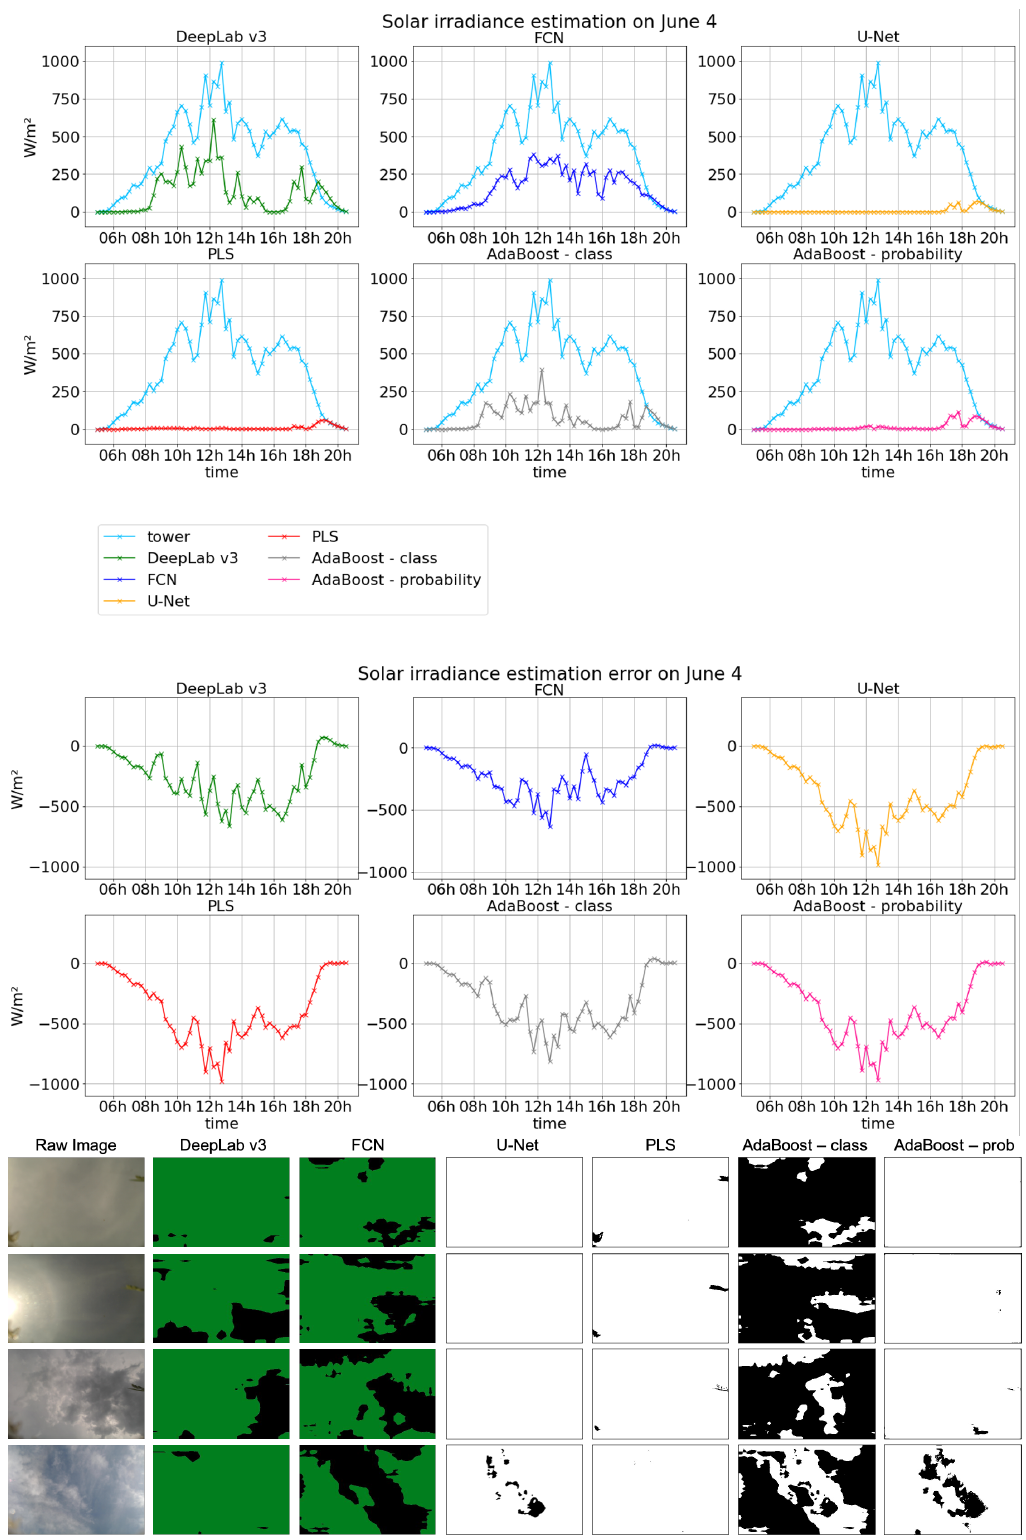
Figure A8. Solar irradiance estimation results based on cloud cover estimation from each machine learning model